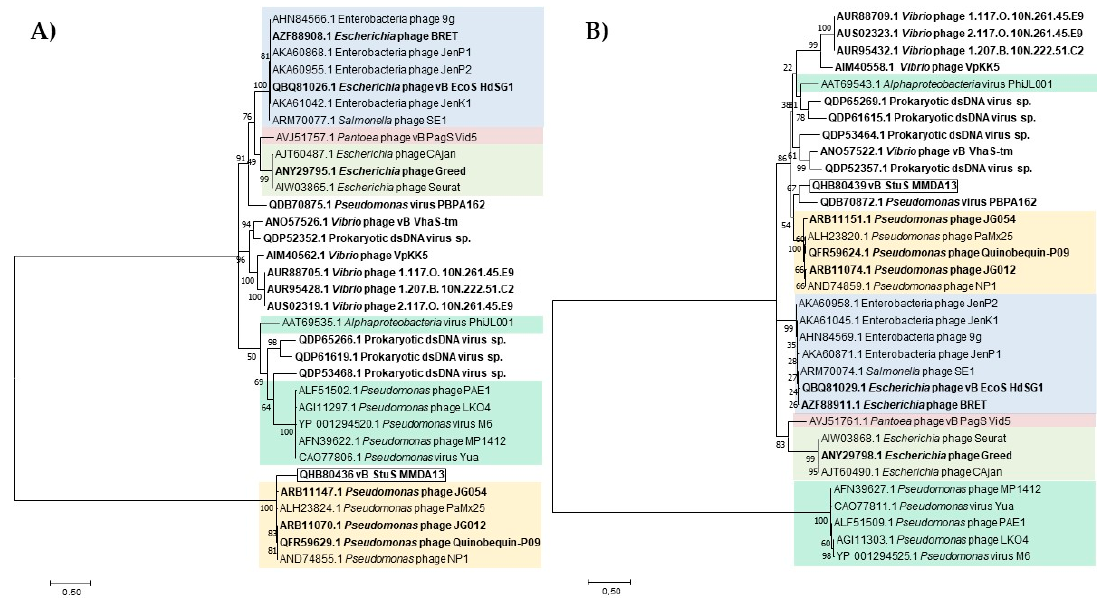
Figure 5. Maximum likelihood trees of terminase large subunits ( A ) and major capsid proteins ( B ). Trees were obtained with MEGA version X by using default parameters and 100 bootstraps. Bootstrap values are indicated next to tree branches. Protein accession numbers are reported for each branch. Colour scheme of different phage genera is as follows: pale blue, Nonagvirus ; pale red, Vidquintavirus ; pale green, Seuratvirus ; green, Yuavirus ; yellow, Nipunavirus . Bacteriophages not classified by ICTV (last accessed 30 July 2020) are in bold.